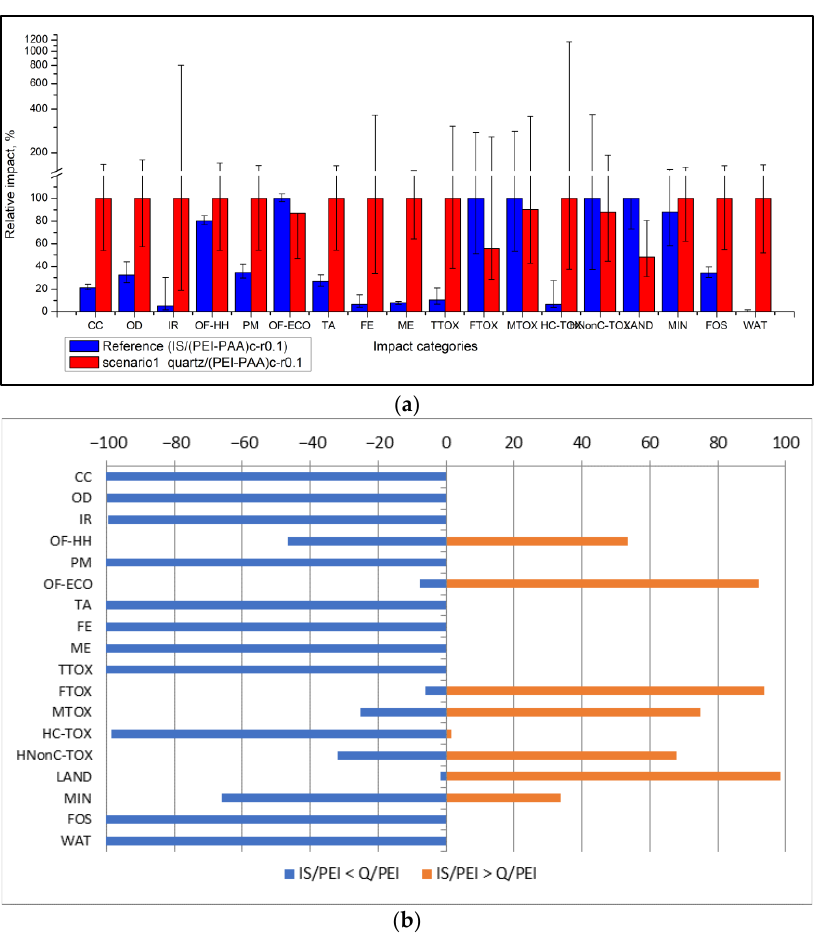
Figure 5. Environmental impacts according to the reference case and Scenario 1 ( a ). Actual impact values ( b ). Probability distribution of differences between the reference case (IS/(PEI/PAA) c (r = 0.1) and Scenario 1 (quartz/(PEI/PAA) c (r = 0.1)).